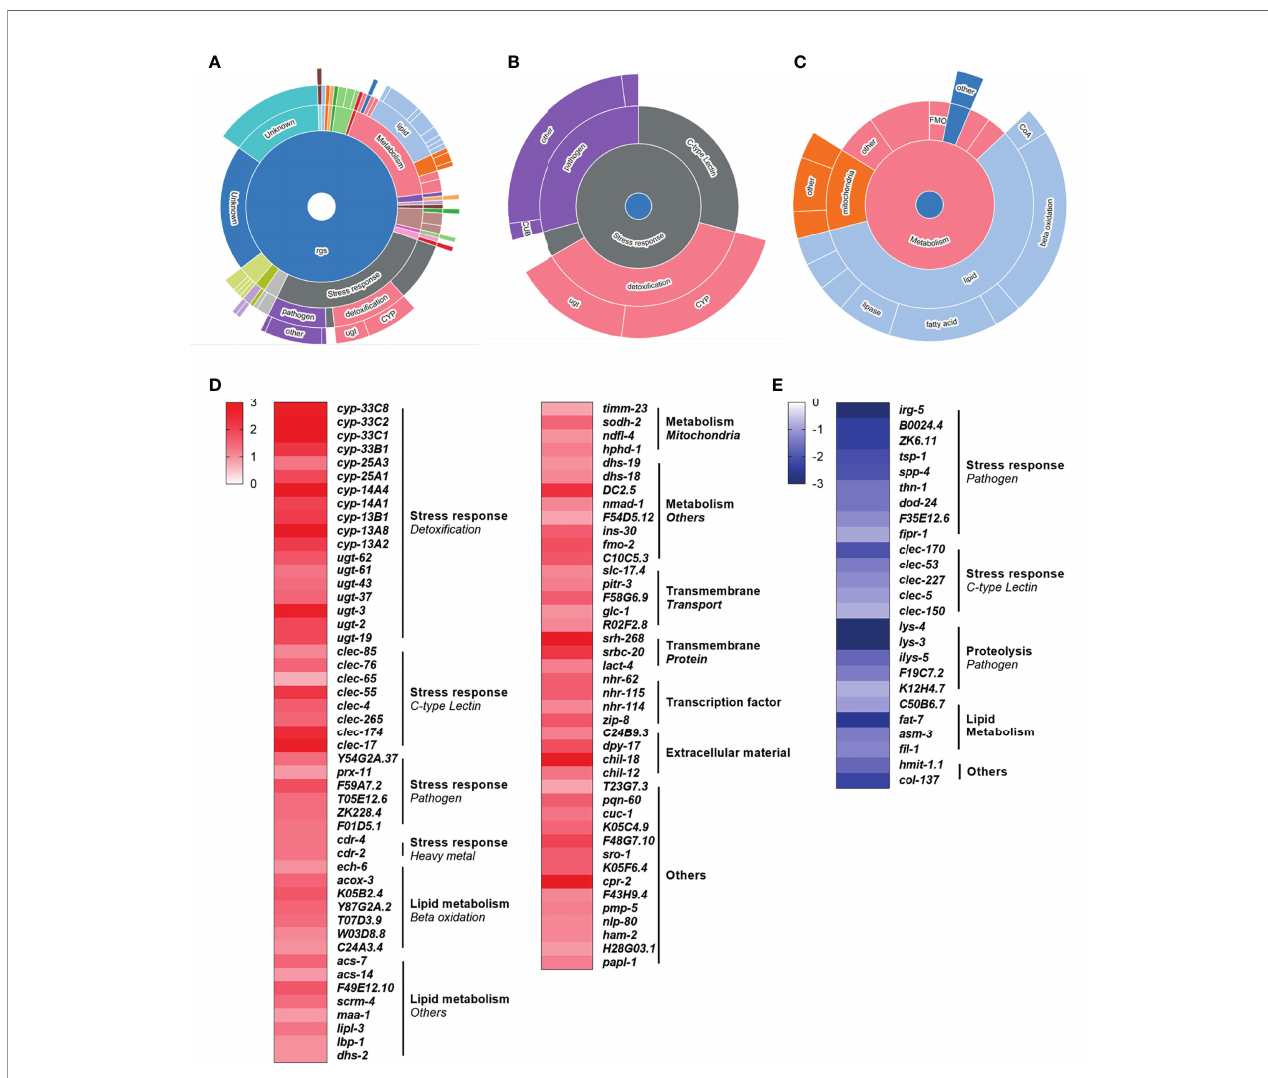
FIGURE 4 | Rotenone modulates genes related to metabolism, immune and stress response pathways. All 179 differentially expressed genes (DEG) from the rotenone treatment were submitted to WormCat analysis for annotation and visualization of enrichment data. (A) Sunburst diagram showing signi fi cantly enriched categories, highlighting the two major broad enriched categories: (B) stress response and (C) metabolism. Heatmap representing the log fold-change of (D) up- regulated and (E) down-regulated genes with known function are shown grouped by gene categories (bold) and subcategories